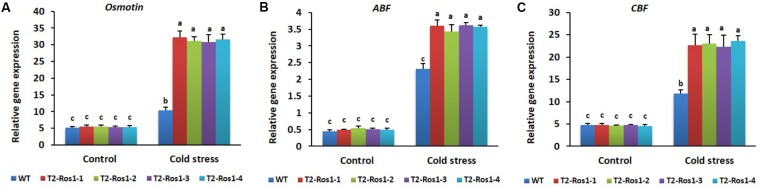
Expression analysis of cold stress-responsive genes (A, Osmotin; B, ABF; C, CBF) in the 9-week-old WT and four independent T2-Ros1 lines under cold stress and normal growth conditions. Data were taken on the 21st day after starting the experiments. NtActin gene was used as reference gene to normalize the transcript levels of the genes. Error bars indicate the SE of means of three replicates. Means with different letters are significantly different (DMRT, p < 0.05).